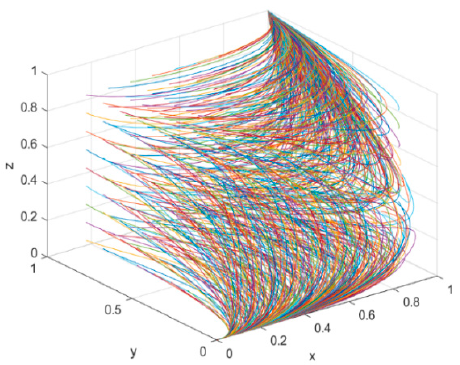
Figure 8. New energy enterprises, government and financial institutions.